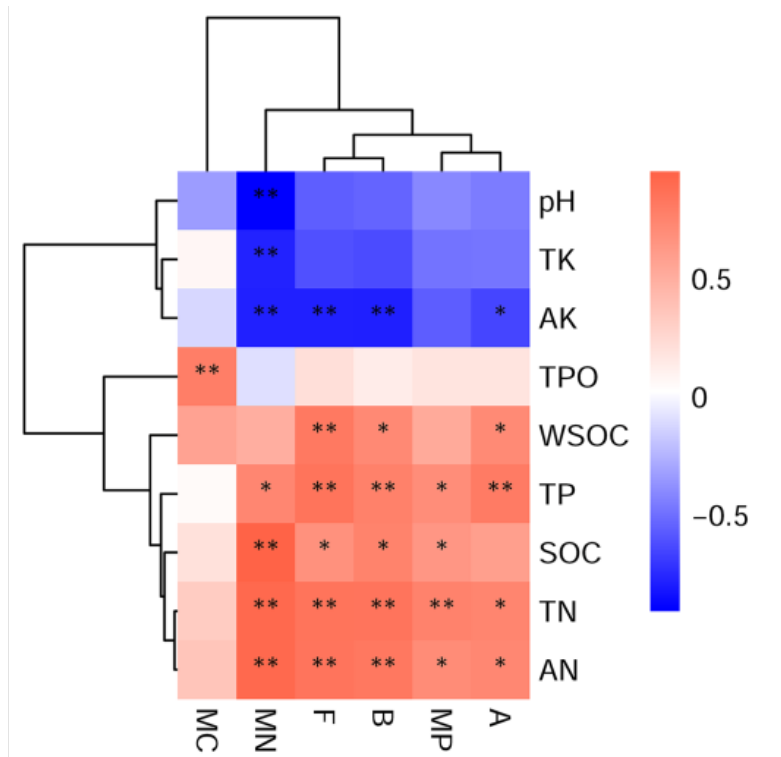
Figure 6. Pearson correlation analysis between soil microbial communities and properties. A, B, and F represent the actinomycetes, bacteria, and fungi. MN, MP, and MC indicate microbial nitrogen, phosphorus, and carbon. TN, TP, TK, TPO, AK, AN, SOC, and WSOC indicate soil total nitrogen, total phosphorus, total potassium, total porosity, and water-soluble organic carbon, respectively. The symbol * and ** indicate significant correlations at p < 0.05 and 0.01, respectively. The colored bar from white to red and blue shows the gradual increasing R 2 value of the positive and negative correlations, respectively.